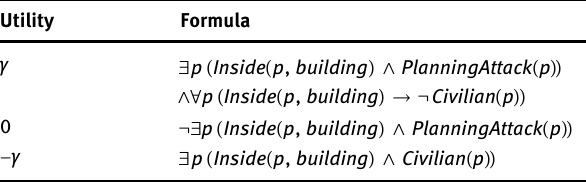
Table 2: Utility ( w.r.t. ρ